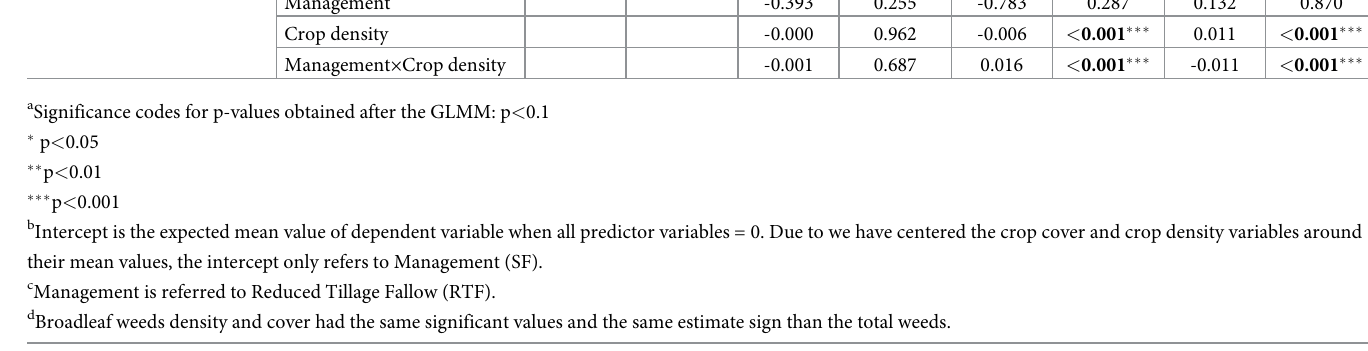
However, seed germination inhibited by light exposure (negative photoblastism) has been determined in Bromus species [60]. Del Monte and Dorado [61] found that ripgut brome ( Bro- mus diandrus Roth) seeds buried or shaded superficially can germinate during fall. Recasens et al. [62] found that germination of ripgut brome was favored by chisel plowing compared to moldboard plowing that buried seeds deeper. Intensive tillage in the SF apparently may have buried seeds and limited their exposure to light, which enhanced germination of downy brome in the following crop. Though the shading effect of crop residue might be greater than seed burial, it can suppress downy brome germination and emergence because it works as a physical barrier that can help with weed control. In RTF, the amount of remained crop residue before seeding is larger than in SF and might have contributed to reduce weed development in the WW. However, non-significant differences in weed infestation between fallow manage- ments in 2017, except for the grass cover in the weedy sub-plots, indicates that when the soil